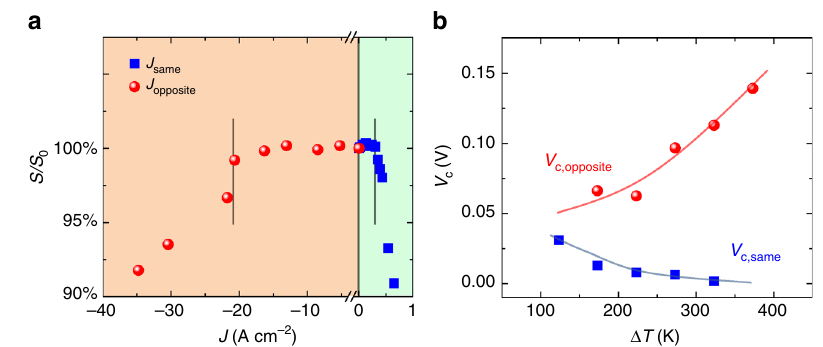
Fig. 3 Critical electric potential difference ( V c ) under a temperature gradient. a The relative Seebeck coef fi cient variation ( S / S 0 ) as a function of the current density for Cu 1.97 S at T cathode = 300 K and T anode = 673 K. The positive J means that the current direction is the same as the heat fl ux direction. The negative J means that the current direction is opposite to the heat fl ux direction. b Experimentally determined V c,same and V c,opposite as a function of | Δ T |, showing qualitative agreement with Eqs. 8 and 9. The temperatures at the anode and cathode for each fl ux direction can be found in text. The length of all measured samples is 6 mm. The dashed lines are guides to